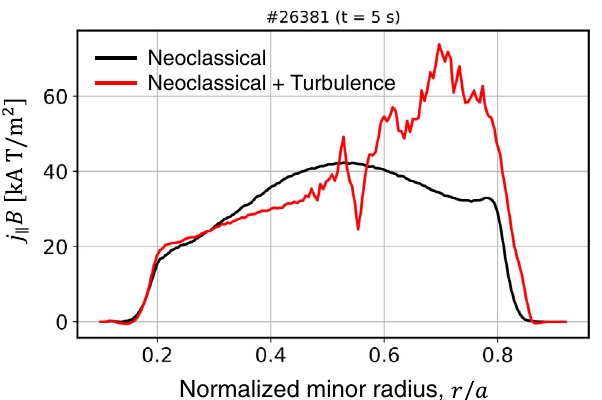
Fig. 7 | Current density pro fi le estimated by the global nonlinear gyrokinetic simulation. The red and black curves represent the current density with and without considering the trapped electron mode (TEM),